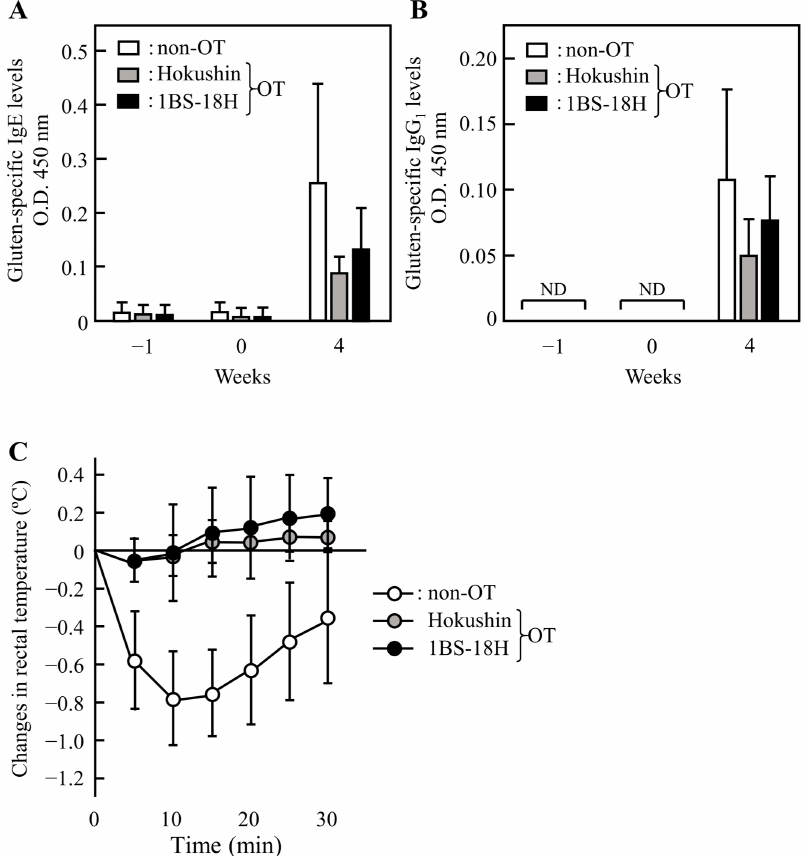
Figure 4. The effects of the oral administration of 1BS-18H gluten on the induction of oral tolerance (OT) to gluten in gluten-immunized rats. The levels of IgE ( A ) and IgG 1 ( B ) Abs specific for gluten in plasma were determined at weeks − 1, 0, and 4 in rats immunized subcutaneously with gluten (week 0) following the oral administration of vehicle alone (50% ethanol, non-OT), gluten from Hokushin (10 mg, Hokushin), or gluten from 1BS-18H (10 mg, 1BS-18H) daily for 5 days. Changes in rectal temperature ( C ) were evaluated after the administration of gluten (2 mg/kg) intravenously at week 4. Each value represents the mean ± SD of four to eight rats. ND, not